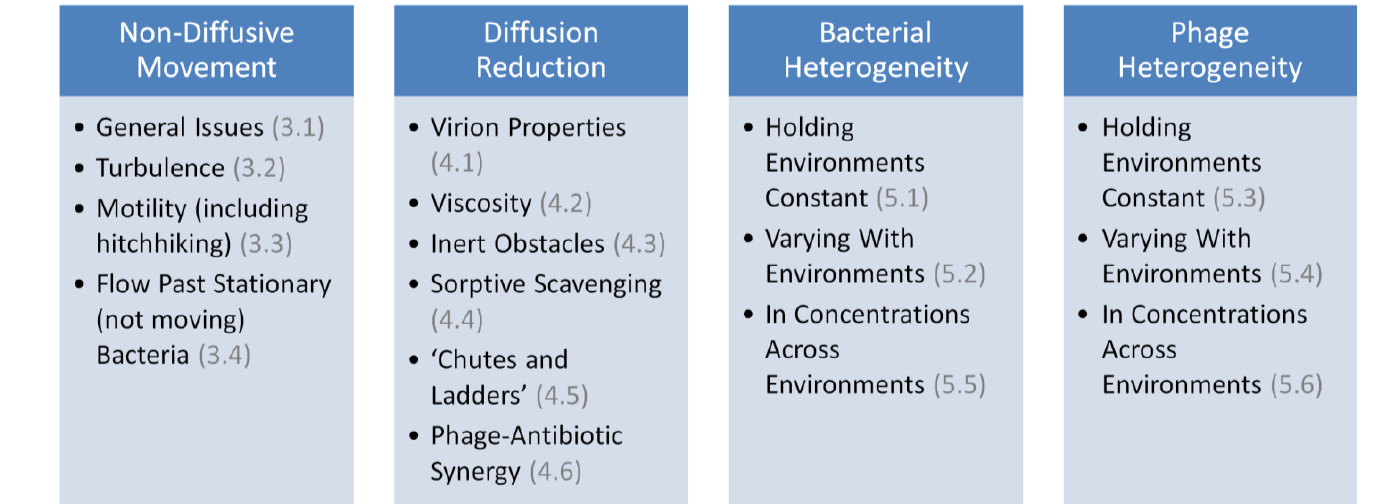
Figure 1. Summary of topics covered. Section numbers are indicated parenthetically, in gray. Not displayed in this summary is Section 2, which considers some theory of phage adsorption, as is considered in additional detail also in Appendix A.